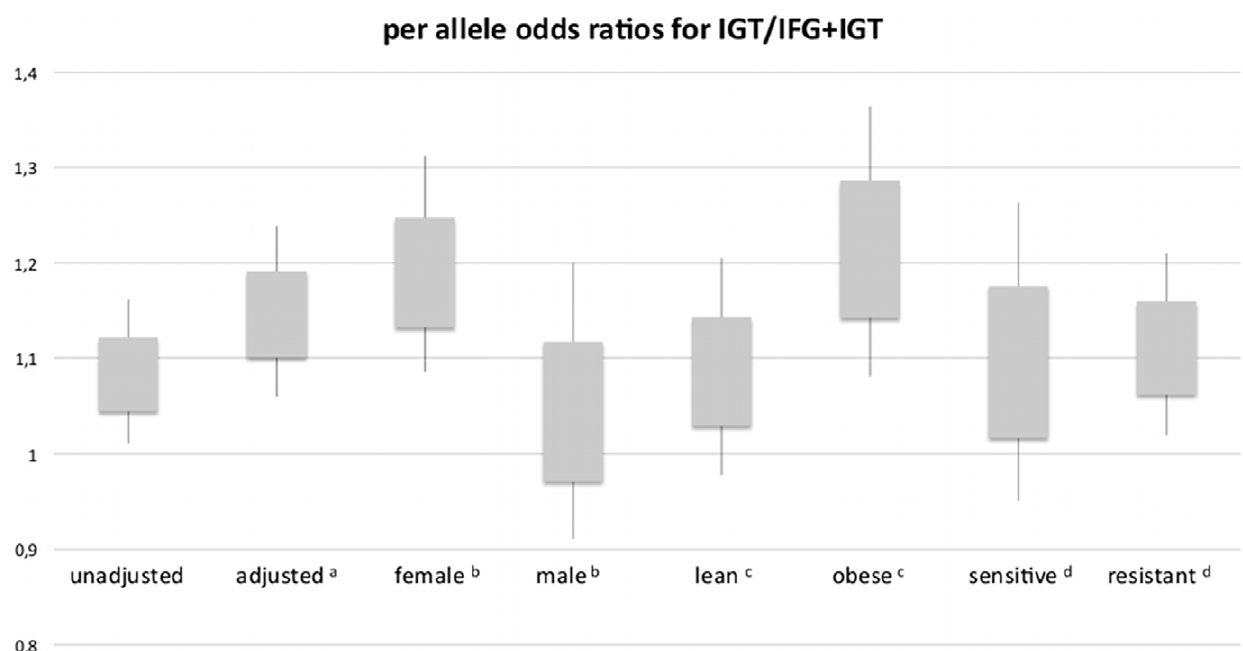
Figure 1. Odds ratios for IGT per risk allele in the whole cohort and in subgroups. Boxes indicate odds ratio 6 standard error; whiskers indicate 95% confidence interval. Overall indicates whole cohort. Lean indicates BMI , 30 kg/m 2 . Obese indicates BMI . =30 kg/m 2 . Sensitive indicates insulin sensitivity index . =14.3. a adjusted for sex, age, BMI and insulin sensitivity; b adjusted for age, BMI and insulin sensitivity; c adjusted for sex, age and insulin sensitivity; d adjusted for sex, age and BMI.